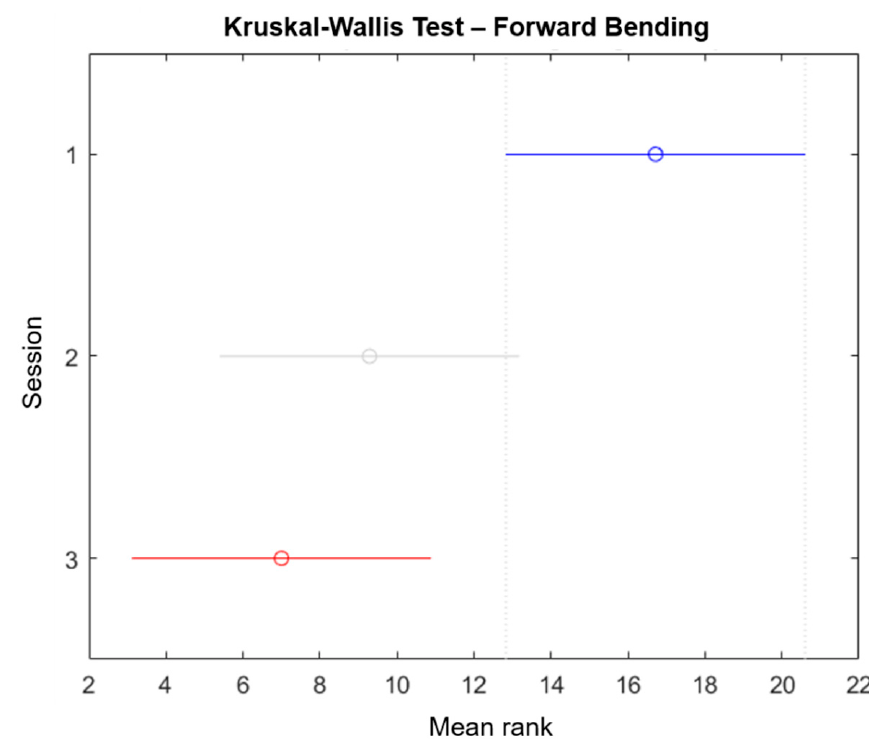
Figure 9. “Multicompare” from the Kruskal–Wallis test for forward bending, where the mean ranks of sessions 1 and 3 are significantly different.